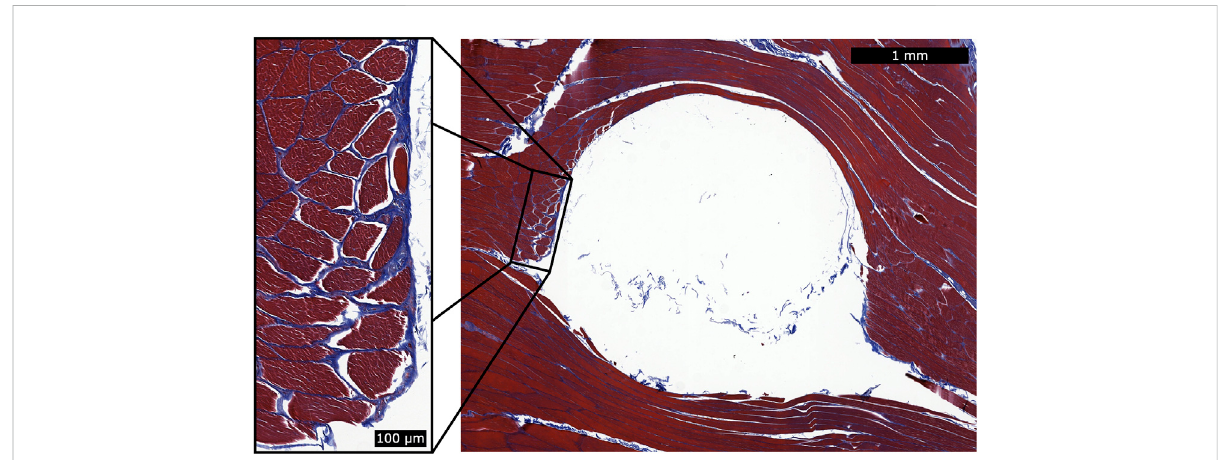
FIGURE 7 Histology for a single magnetic bead implant. This representative histology sample shows a cross section of the implantation site after removal of the spherical magnetic bead implant. We applied Masson ’ s trichrome staining to highlight the fi brous tissue in blue. During explantation, some of the fi brous capsule remained attached to the implant and thus was generally unobservable in the histological analysis. However, a thin fi brous wall remained(seemagni fi edinset),andthe fi broustissuehadintegratedintothemuscle fi bers.Thisobservationsuggeststhatthe fi broustissuemay contribute to holding the implant in position relative to the surrounding muscle tissue. No in fl ammation was observedsurrounding the implantation sites.